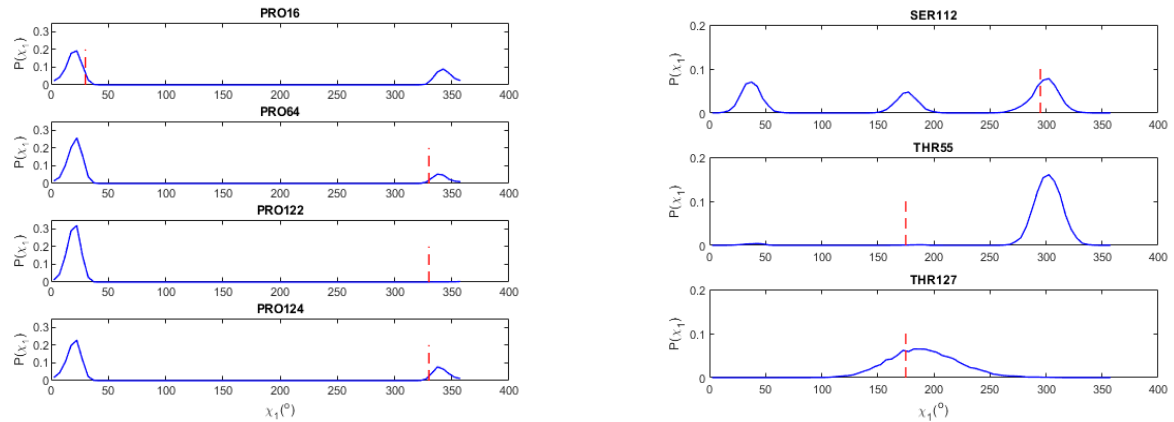
Figure 4. Side-chain torsions probability density distributions P( χ 1 ) (solid blue lines) for Pro16, Pro64, Pro122, and Pro124 ( left column ) and Ser112, Thr55, and Thr127 ( right column ). Values of χ 1 angles observed in the experimental Hyp-1 model were marked as dashed red lines.